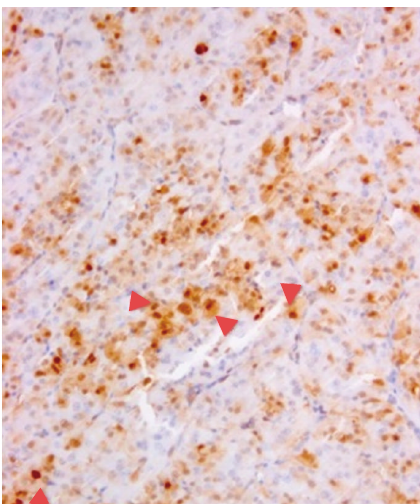
Figure 3: Immunohistochemical features. It should be noted that also Hashimoto thyroiditis may show reactivity for Galectin-3, but it is typical focal and restricted to epithelial cells in the areas of lymphocytic infiltrations. Immunostaining with cyclin D3 with a diffuse and strong reaction in OC.